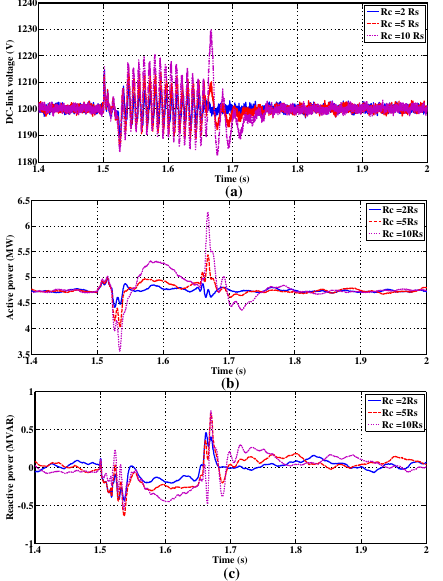
Fig. 13 Variation of measured values during double-phase to ground fault with different CBFT resistances ( a ) DC-link voltage; ( b ) active power; ( c ) reactive